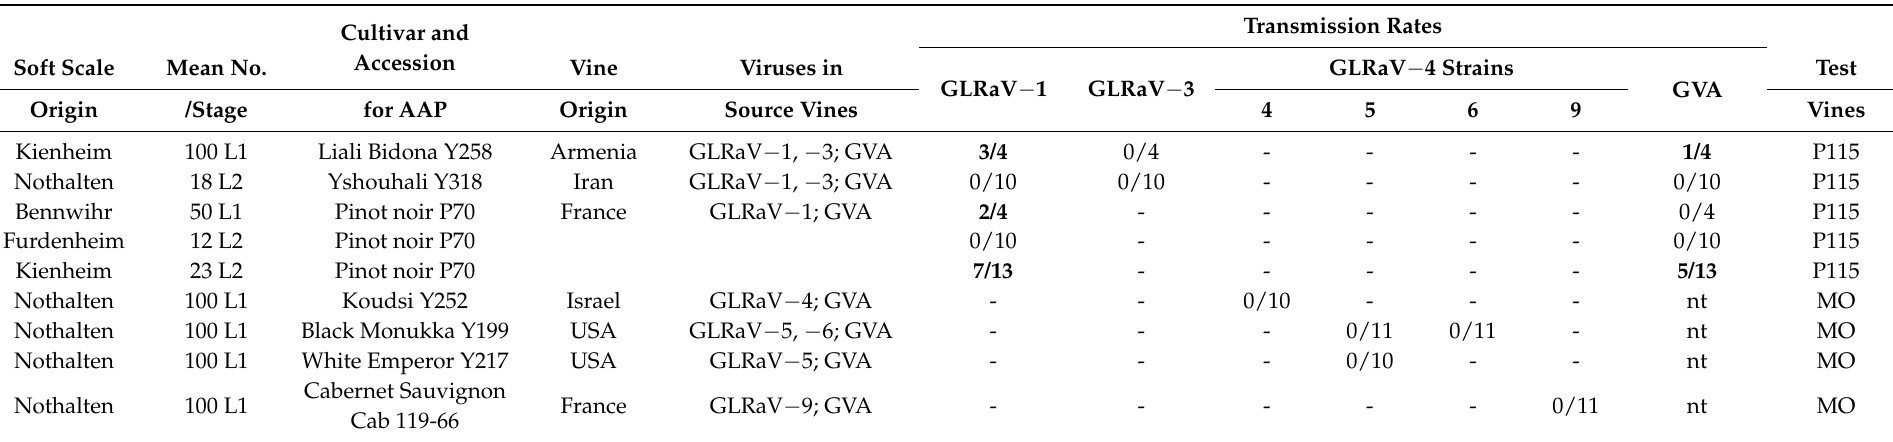
Table 2. Outcomes of transmission experiments performed with L1 and L2 nymphs of Pulvinaria vitis , according to nymph origin, cultivar, and virus association in source vine. Transmission rate = number of positive plants/number of inoculated plants, nt = not tested. Transmission events are in